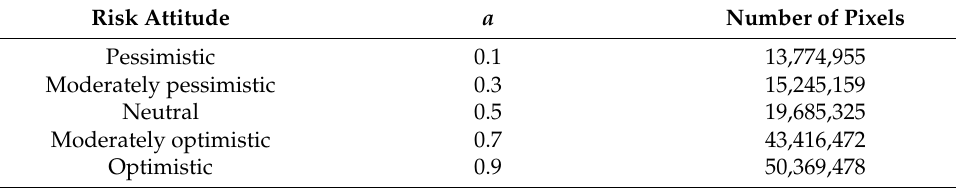
Table 3. The number of pixels of the roof water inrush risk areas in Figure 10.